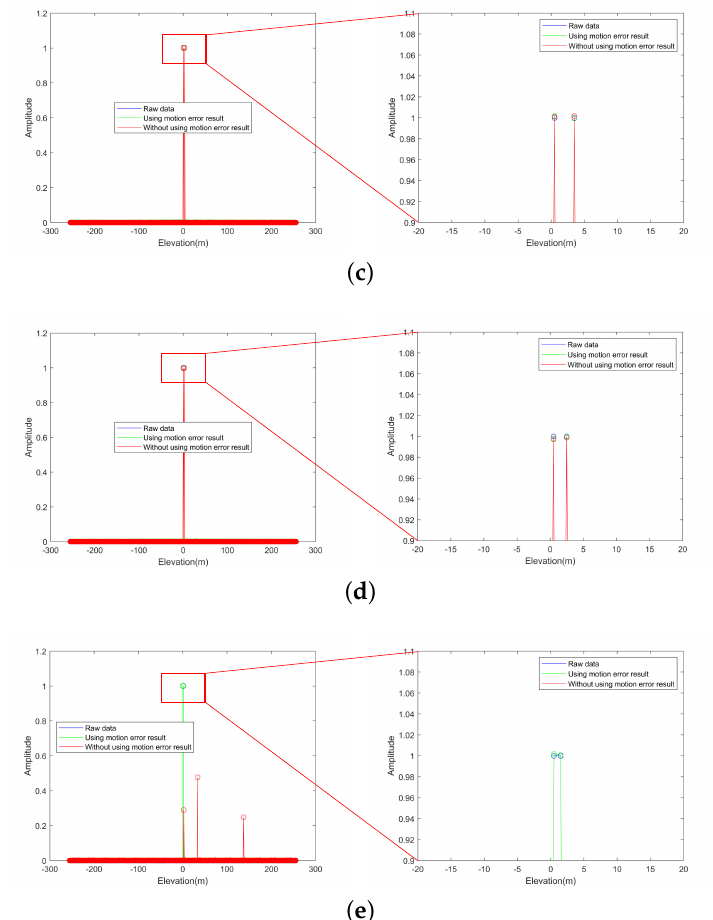
Figure 9. Comparison of scattering point reconstruction performance (using motion error(the pro- posed method) compare without using motion error (BP algorithm)). ( a ) Two targets interval 5 m and zoom of the highest point. ( b ) Two targets interval 4 m and zoom of the highest point. ( c ) Two targets interval 3 m and zoom of the highest point. ( d ) Two targets interval 2 m and zoom of the highest point. ( e ) Two targets interval 1 m and zoom of the highest point.